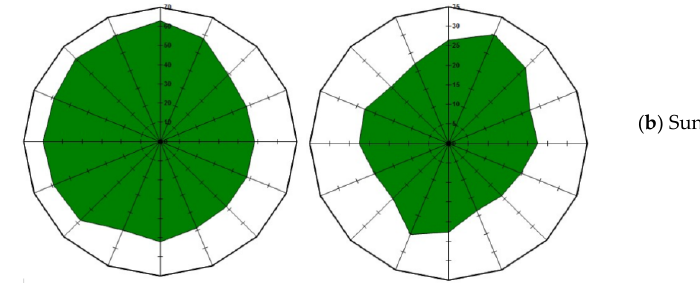
Figure 12. Concentration (radius, ppb) versus wind direction (angle) polar plot over 24 h.